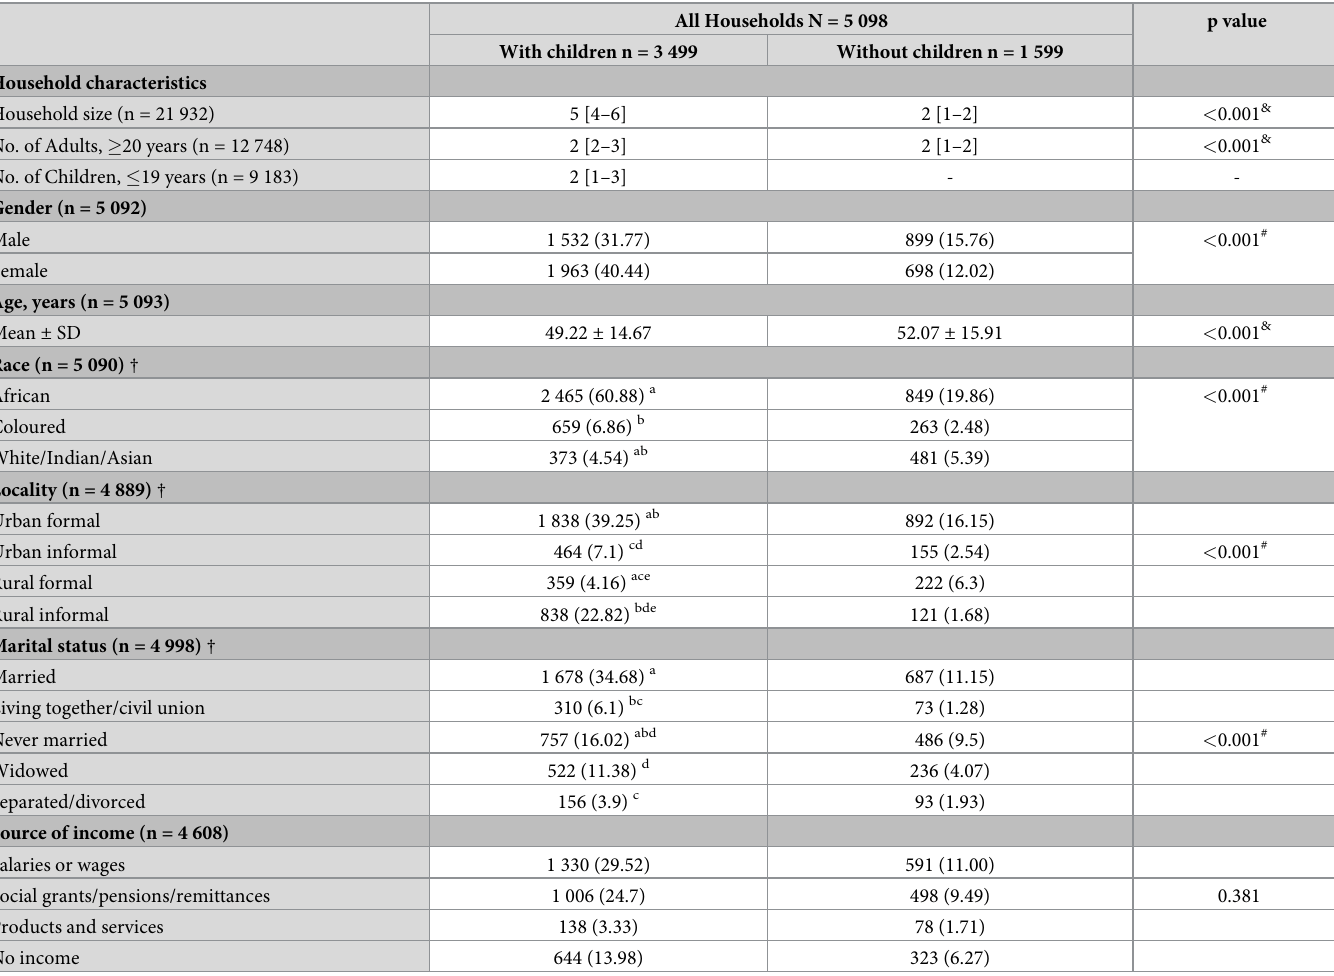
Table 1. Characteristics of occupied South African households with and without children, and sociodemographic characteristics of household heads. All Households N = 5 098 p value With children n = 3 499 Without children n = 1